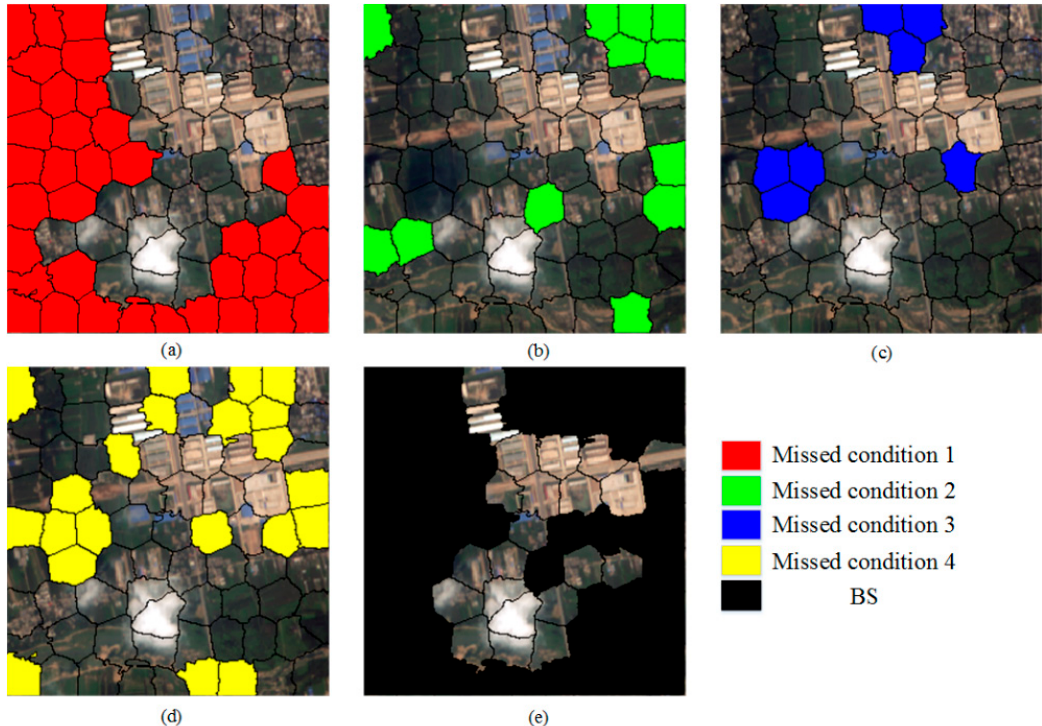
Figure 7. Example showing BS extraction based on four conditions. ( a ) Superpixels that missed condition 1; ( b ) Superpixels that missed condition 2; ( c ) Superpixels that missed condition 3; ( d ) Superpixels that missed condition 4; ( e ) BS extraction result.